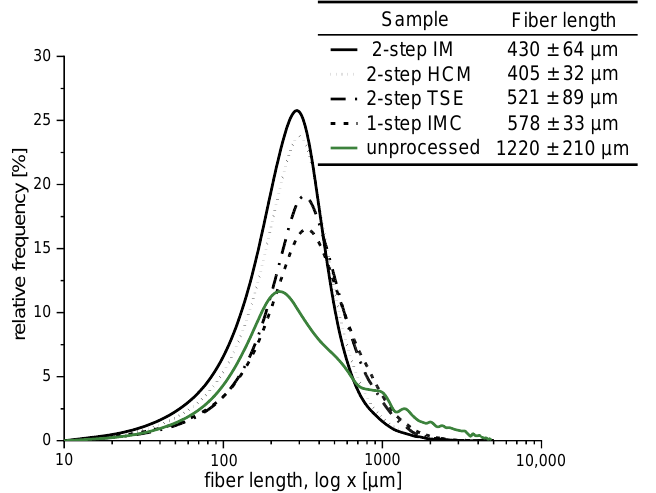
Figure 3. Residual arithmetic fiber length distribution (unrolled) in the component according to ISO 9276; n = 3; 𝑋̅ ± 𝑆𝐷 ; minimum number of measured objects >30,000